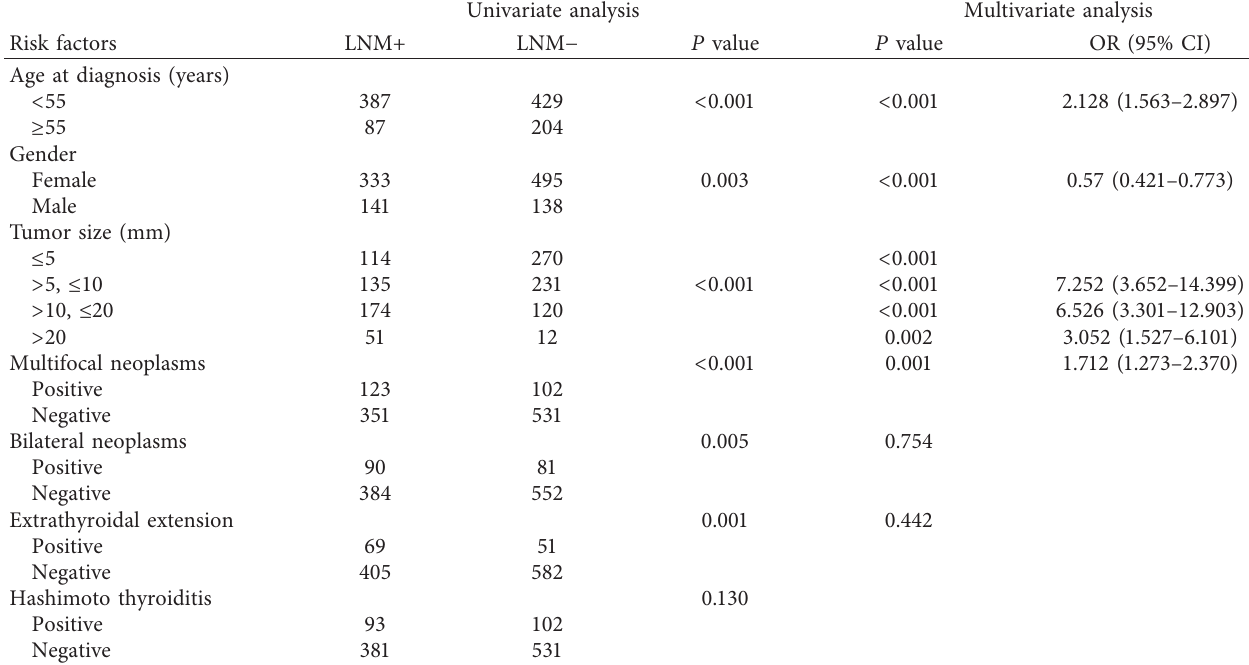
Table 3: Univariable and multivariate analysis for LNM.